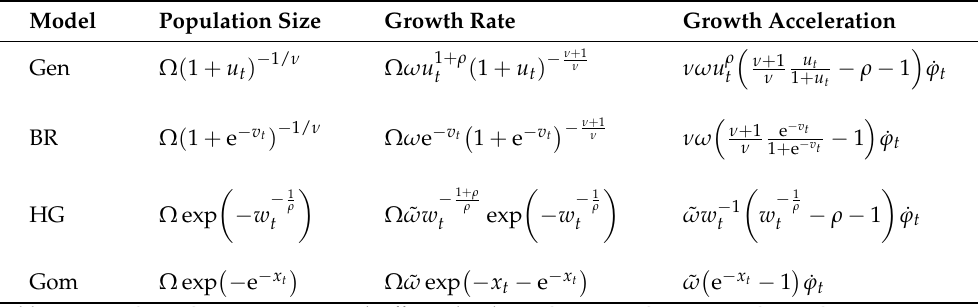
Table notes: Gen, Generic; BR, Bertalanffy–Richards; HG, Hyper-Gompertz; Gom, Gompertz; u t